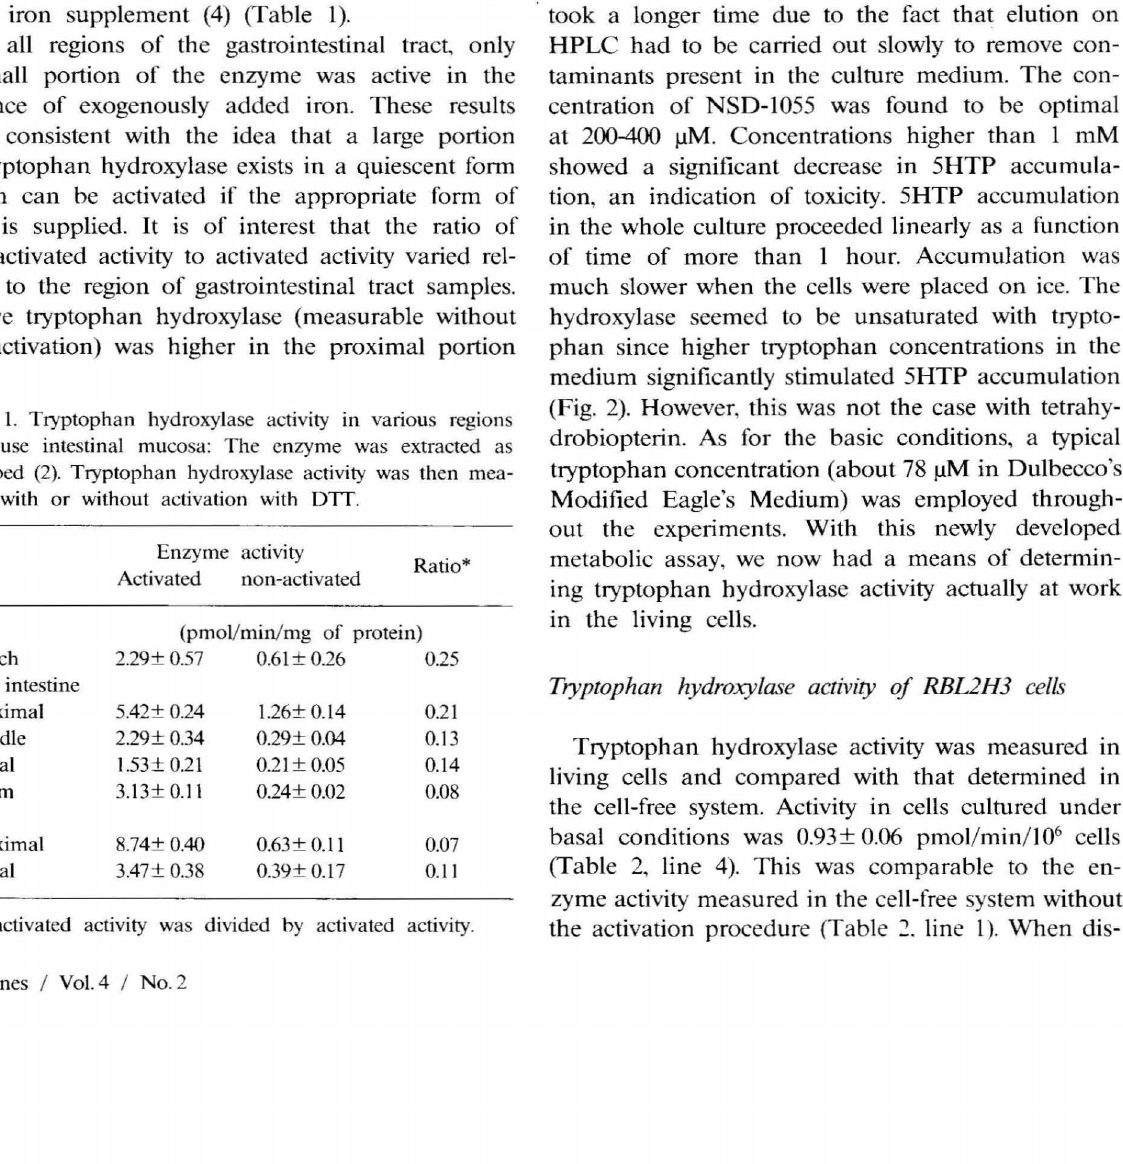
(Table 2, line 4). This was comparable to the en zyme activity measured in the cell-free system without the activation procedure (Table 2. line I). When